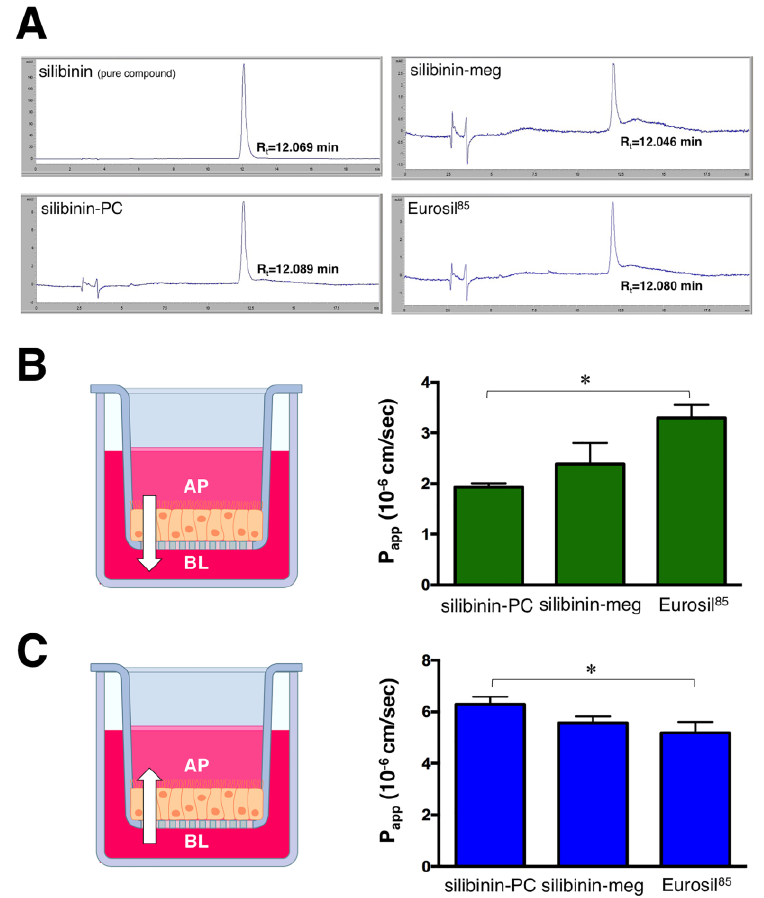
Figure 1. P app values of the different formulations of silibinin. Representative HPLC elution profiles and retention times of silibinin formulations after 120 min incubation with the Caco-2 cell monolayers ( A ). P app values in cm/s for silibinin formulations in both AP–BL ( B ) and BL–AP ( C ) directions. Each column represents the mean ± standard deviation (SD) of P app values obtained in n = 6 independent replicates. * One-way ANOVA p < 0.0001; AP: Apical; BL: Basolateral; silibinin-PC: silibinin-phosphatidylcholine; silibinin-meg: